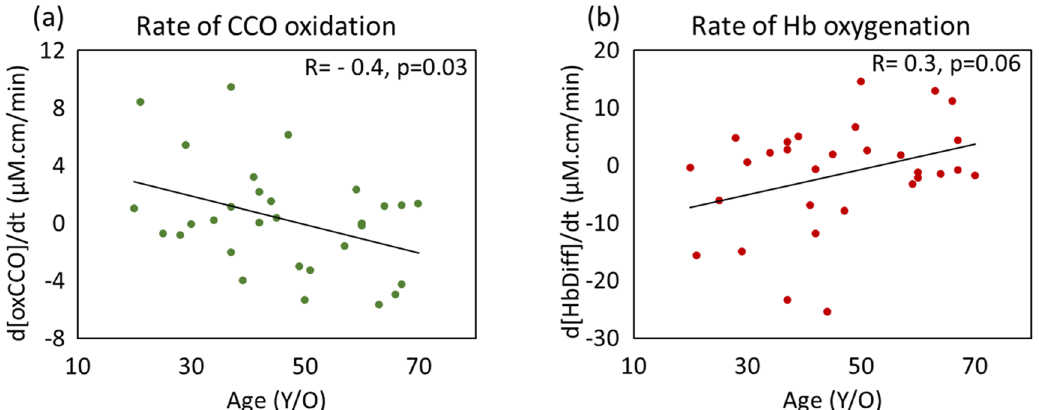
Figure 2. Rate of mitochondrial oxidation ( a ) and retinal oxygenation ( b ) measured at t = 15 min for all the subjects with age (N = 30). ( a ) There is a mild-moderate age-related decline in CCO oxidation rate (rate of change in concentration of oxidized cytochrome-c-oxidase (Δ[oxCCO]) in dark (Pearson correlation coefficient R = −4 and coefficient p value, p = 0.03). ( b ) Rate of hemoglobin oxygenation (rate of change in hemoglobin difference (Δ[HbDiff])) has a mild positive association with age which is not statistically significant (Pearson correlation coefficient R = 0.3 and coefficient p value, p =